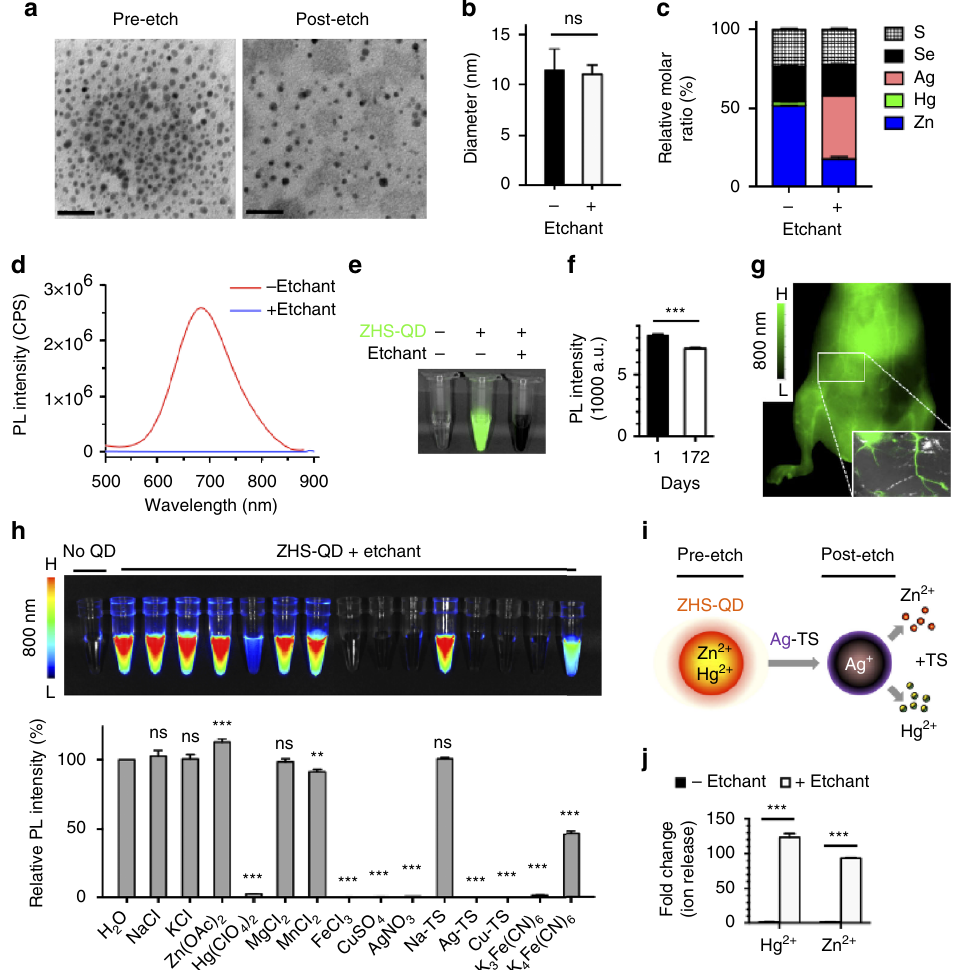
Fig. 1 Characterization of etchable ZHS-QDs. a , b , d TEM images a hydrodynamic diameters b and PL spectra at 450 nm excitation d of ZHS-QDs before and after Ag-TS treatment. n = 6 per group; Scale bars , 50 nm. c EDS analysis of ZHS-QDs before and after Ag-TS treatment. Refer to Supplemental Table 1 for complete data set. n = 3 per group. e NIR image of ZHS-QDs (green) with and without Ag-TS treatment taken with a Li-Cor Pearl imager under an 800 nm channel. f NIR signals of ZHS-QDs quanti fi ed at days 1 and 172 post-synthesis. n = 5 per group. g NIR images of the ventral side of a mouse intravenously injected with ZHS-QDs. Inset, ex vivo NIR image of the skin. h In vitro etching of ZHS-QDs by various chemicals. NIR images ( upper panel ) and the emission intensity of the ZHS-QDs before and after etching ( bottom panel , n = 4 per group) are shown. Each column corresponds to the tube above. i Schematic of ZHS-QD etching. Ag-TS quenches ZHS-QDs by providing Ag + in exchange with Zn 2+ and Hg 2+ . j Hg and Zn released from ZHS-QDs with and without Ag-TS treatment. Columns represent fold over non-etched group. n = 3 per group. Statistics, Student ’ s t -test b , f , j or one-way analysis of variance h ; error bars , SEM; ns, not signi fi cant; ** P < 0.01; *** P <